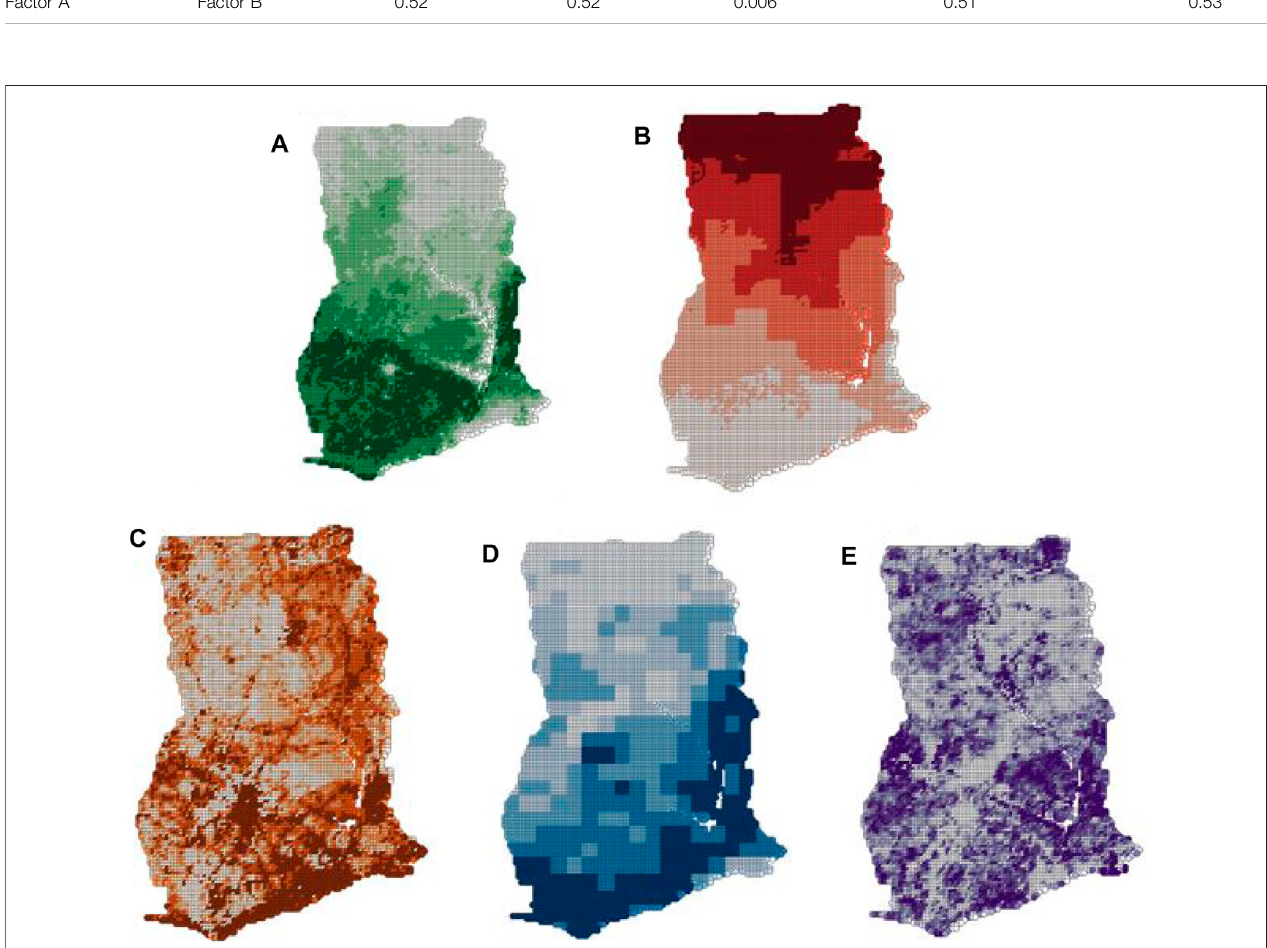
FIGURE8 | Maps ofstandardized latent vector scoresobtained from thePLSPM: (A) Factor A; (B) Factor B; (C) Factor C; (D) Factor D; (E )FactorE. Values range from − 1.96 to 1.96, darker colors denote negative values. Note that the gradient is reversed for (B) and (C) for clarity.